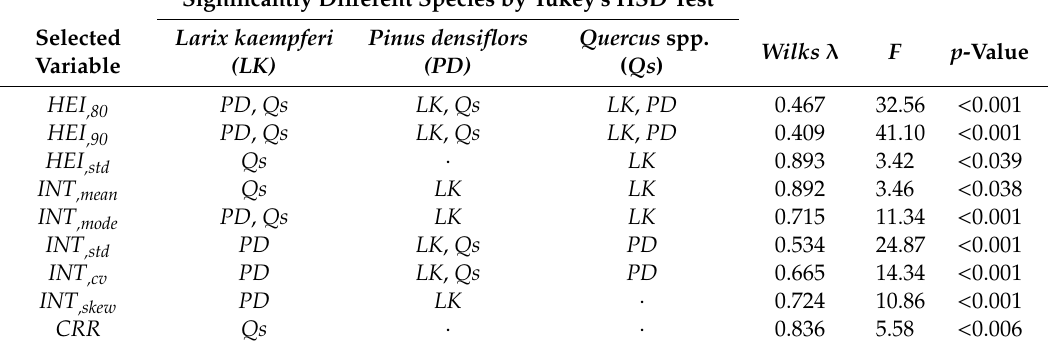
Table 2. Results of stepwise selection and Tukey’s HSD test for plot dominant species discrimination (both under 0.05 significant